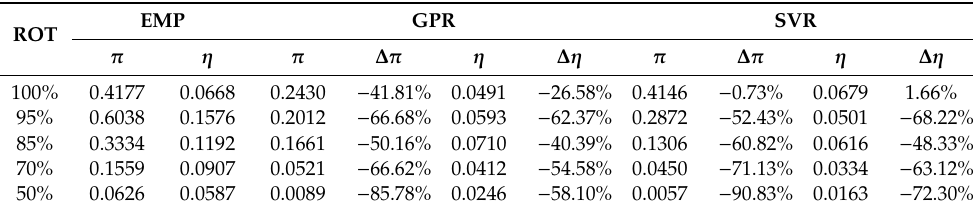
Table 5. RMSE of di ff erent models compared to experimental data for whole rotatioinal speeds and the percentage of error increment relative to